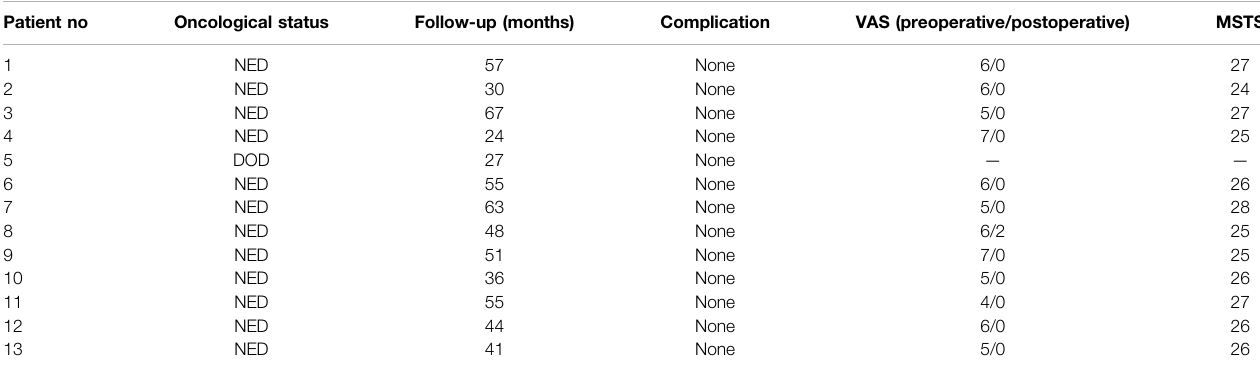
TABLE 3 | Results for patients undergoing femoral reconstruction with an intra-neck curved stem endoprosthesis. Patient no Oncological status Follow-up (months) Complication VAS (preoperative/postoperative)